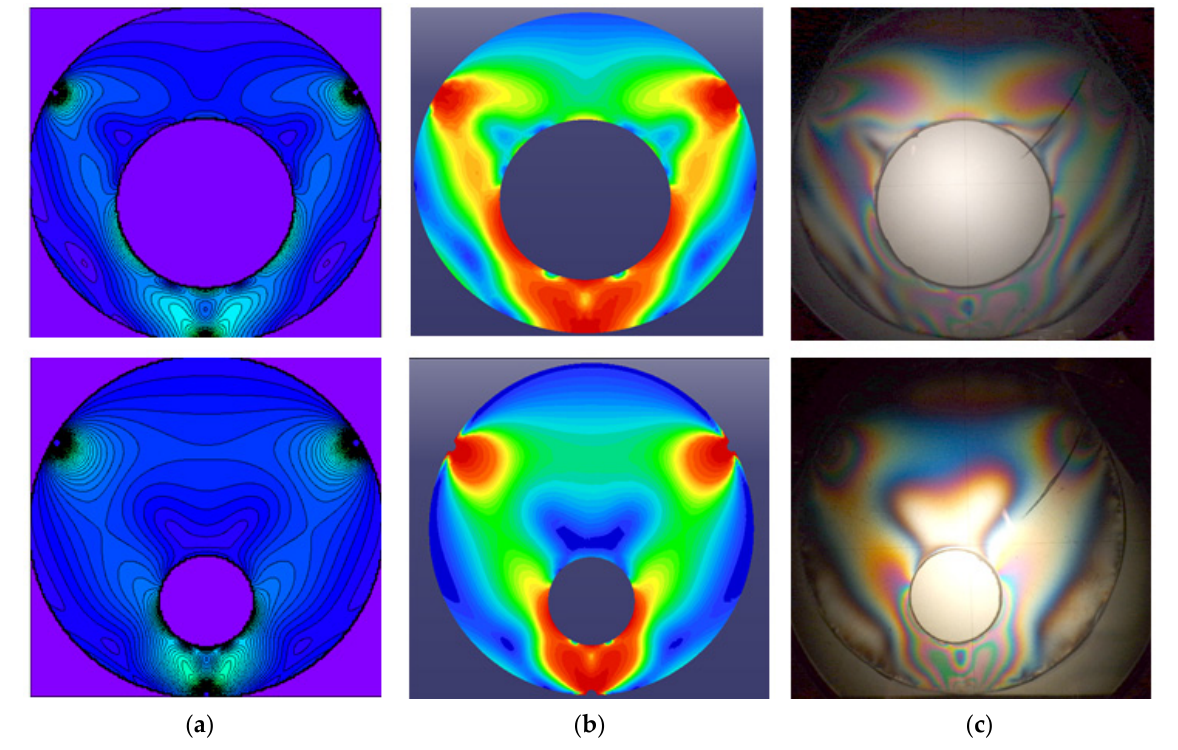
Figure 18. Isochromatic fields for two geometries of the ring compressed by three equidistant forces (loading Case c, Table 1): theoretical ( a ), numerical ( b ) and experimental ( c ) results.